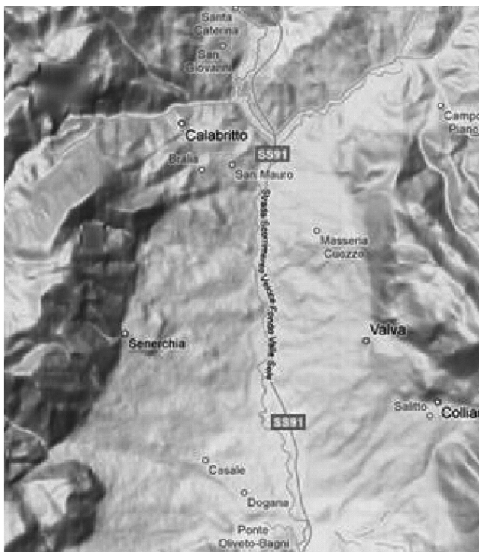
Fig. 1. Area under study with indication of the Sele river location near the